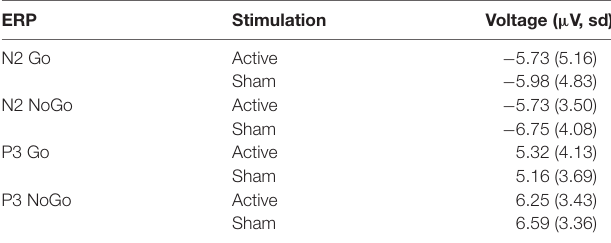
TABLE 5 | ANOVA table of the frontal N2 peak amplitudes.